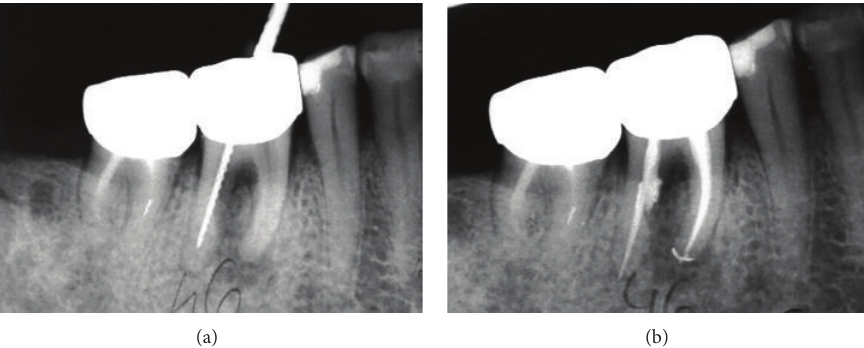
Figure 2: (a) The endodontic lesion extended from the apex of the mesial root of tooth 4.6. towards the furcation dome, causing an external resorption of the mesial aspect of the distal root. (b) The regular shaping with nickel-titanium (Ni-Ti) instruments of the distal canal resulted in stripping with extrusion of the filling material, which became obvious only on postoperative radiographic